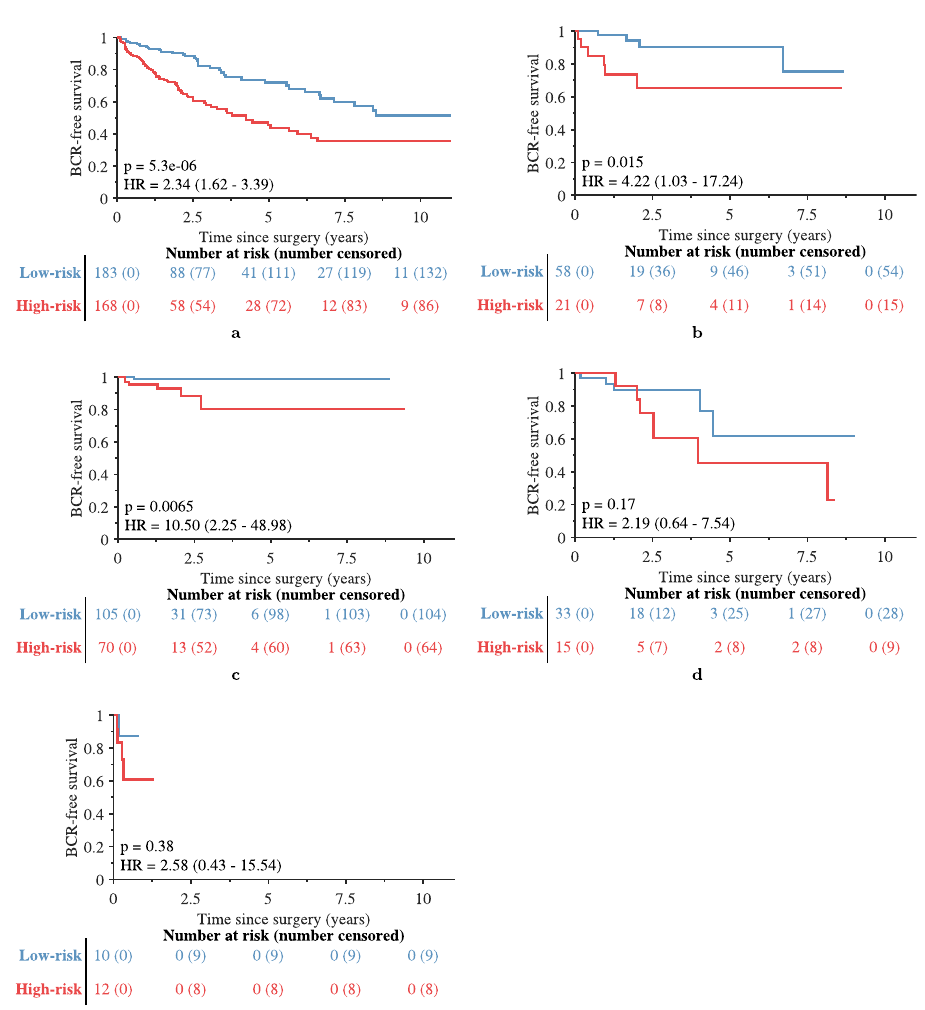
Fig. 3 Kaplan-Meier BCR-free survival plots of patients from each site. Patients from a UPenn, b WCM, c TCGA, d UTurku, and ( e ) MS are categorized as (blue) low-risk and (red)